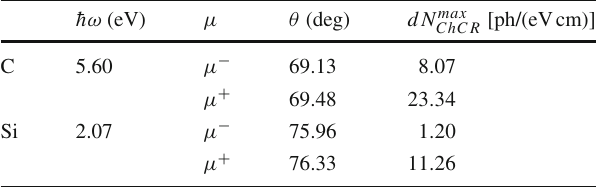
Table 2 Maximum number of ChCR photons hitting the photon detec- tor of the angular size Δθ = Δϕ = 0 . 3 mrad emitted by μ − and μ + muons in both C and Si crystals under the azimuth angle θ